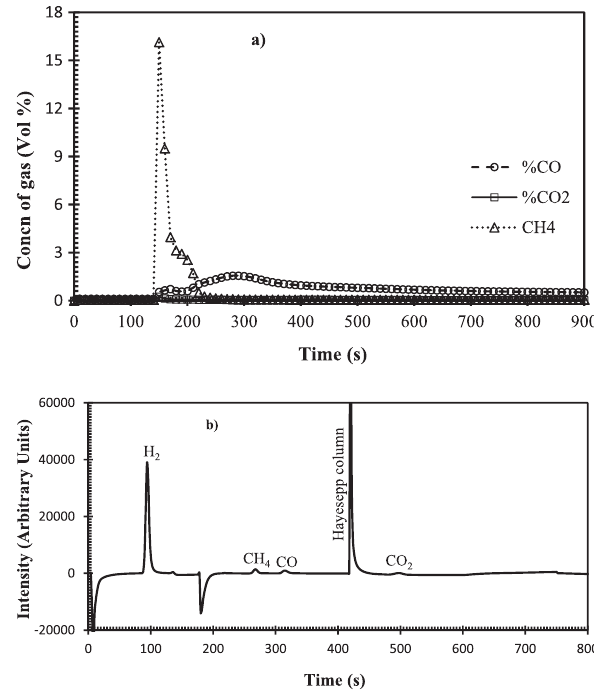
Fig. 5: Gas generation behaviour during the thermal decomposition of PP from a PP-alumina compact: a) results from IR analyser b) gas chromatogram obtained after 60